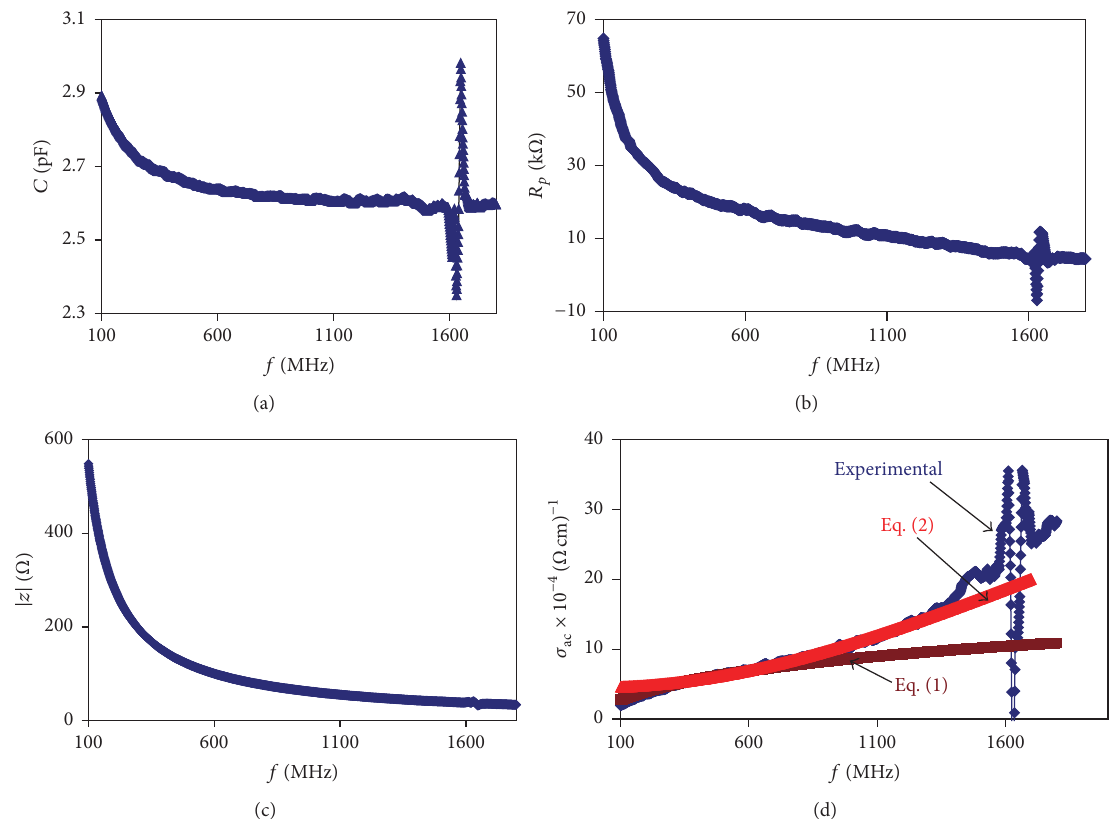
Figure 4: (a) The capacitance, (b) the parallel resistance, (c) the total impedance, and (d) the conductivity spectra for the Au/BN/C device.